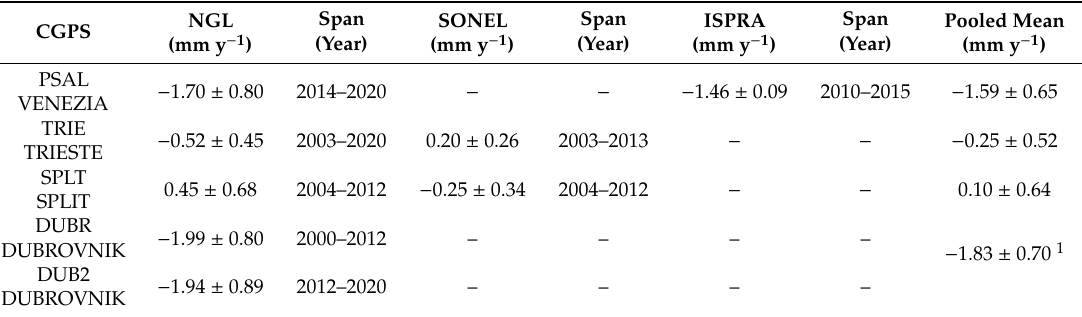
Table 2. Geocentric surface vertical velocities at four locations from CGPS stations. Column 1: station name; columns 2–3 / 4–5 / 6–7: VLM rate and time span calculated by NGL / SONEL / ISPRA; column 8: pooled means of given rates for the four CGPS